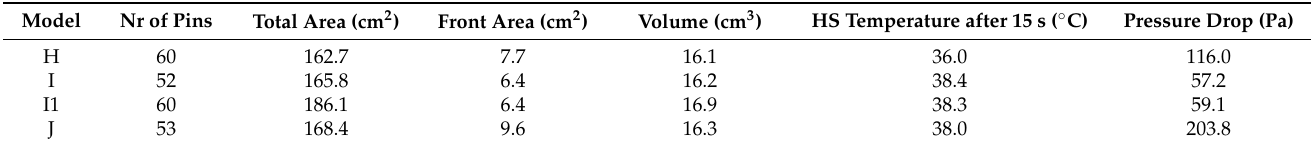
Table 9. Temperature and pressure drop for each pin heat sink